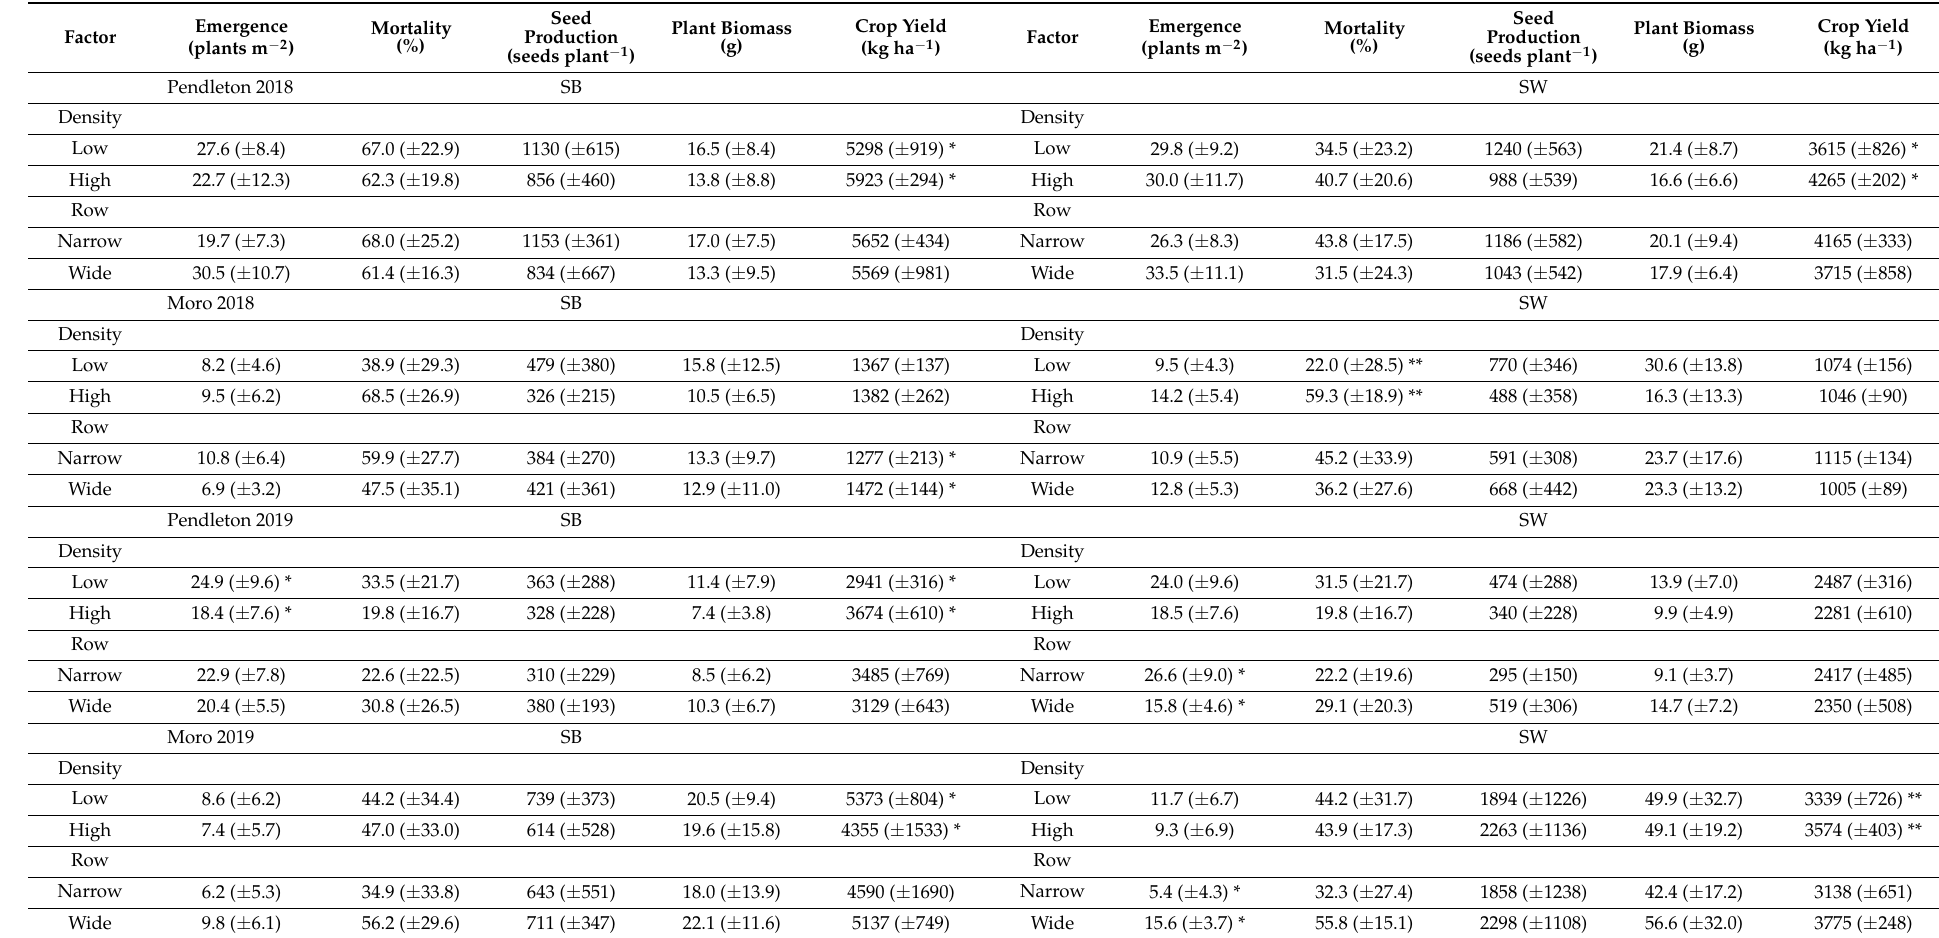
Table 2. Effect of row spacing (Row) and crop seeding rate (Density) on Russian thistle emergence, mortality, seed production, plant biomass, and crop yield (mean ± standard deviation) in two locations (Pendleton and Moro) over two years (2018 and 2019) with spring barley (SB) and spring wheat (SW). All means were compared with Tukey’s